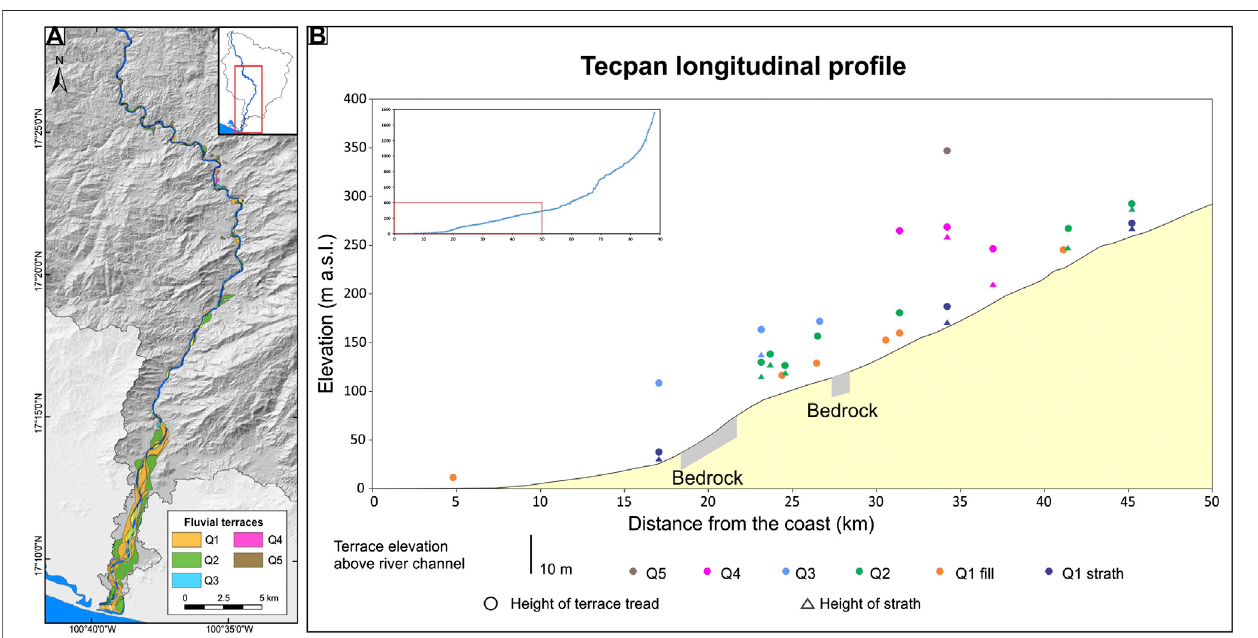
FIGURE5| River terraces alongtheTecpanRiver. (A) Distributionofmappedterraces. (B) Longitudinalpro fi leoftheTecpanRiver withlocationand heightsabove the valley fl oor of fl uvial terraces.